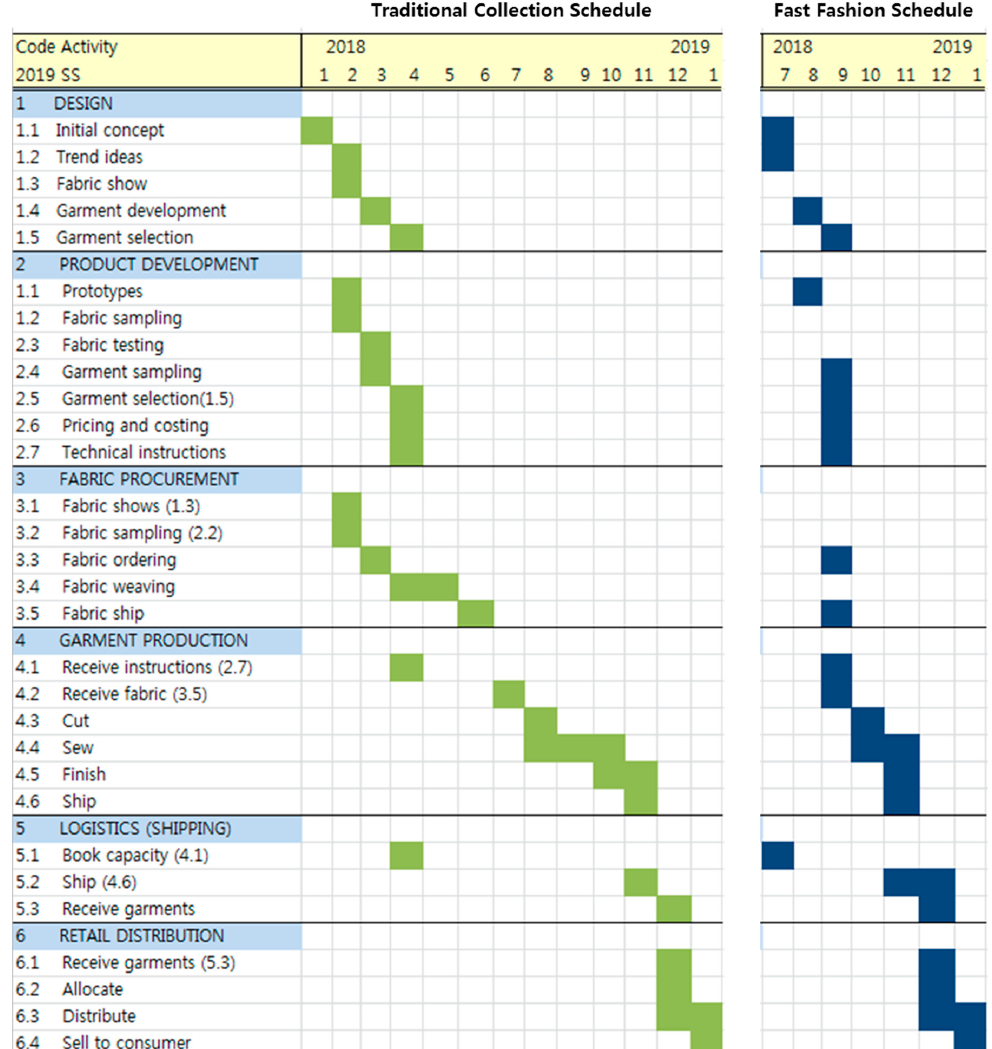
Figure 16. Fashion planning and production process supply chain schedule.